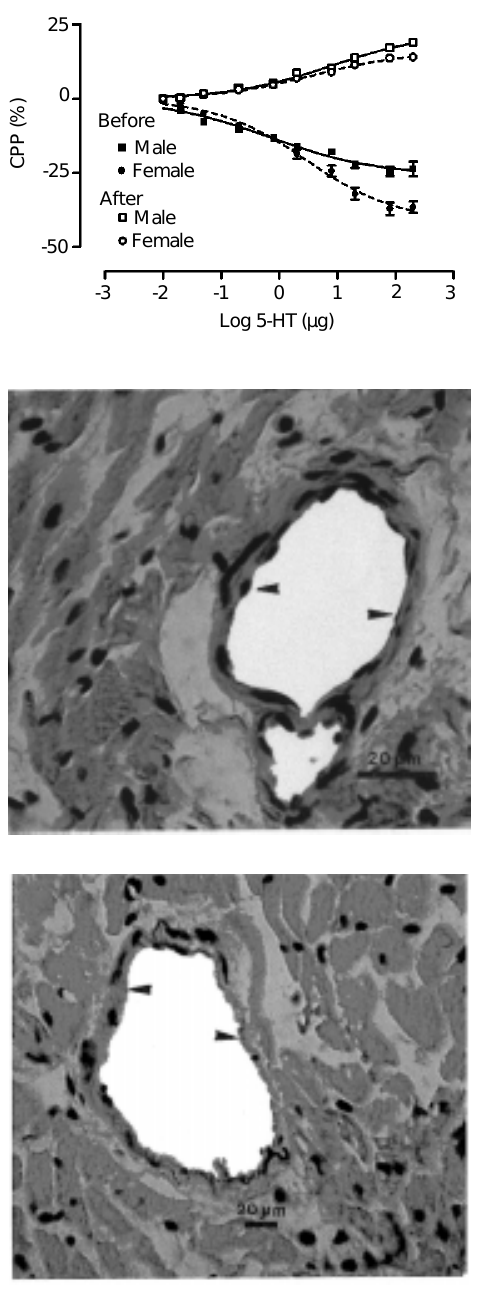
picture).Figure 4. Dose-response curves for coronary vasodilation pro- duced by serotonin (5-HT) in iso- lated hearts from naive male (N = 9) and female rats (N = 9) be- fore (closed symbols) and after (open symbols, N = 10) endothe- lial denudation by treatment with 2 mg/ml deoxycholic acid in the perfusate for 10 min. Each sym- bol and bar indicate the mean ±